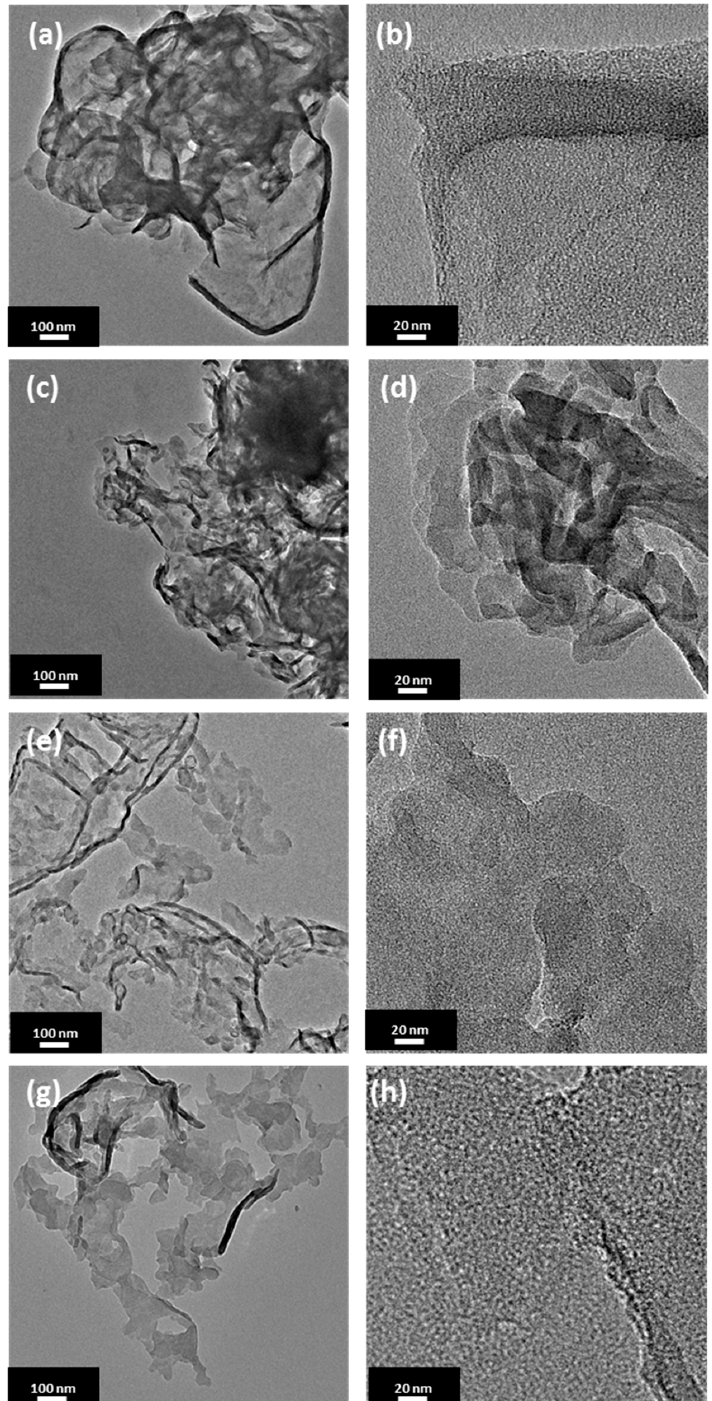
Figure 1. Transmission electron microscopy (TEM) images of polymeric carbon nitride prepared under different temperatures with 4 °C/min. of heating rate: ( a , b ) 500-4, ( c , d ) 520-4, ( e , f ) 550-4, and ( g , h ) 600-4.